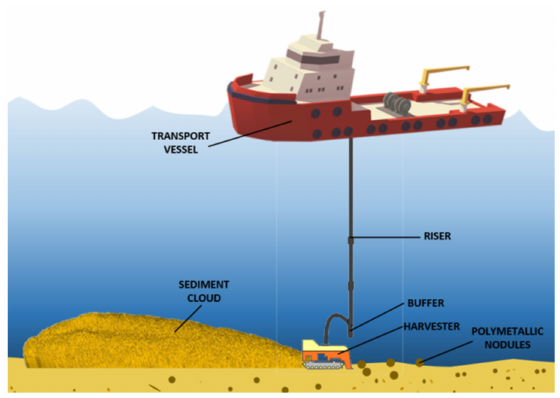
Figure 1. Diagram of harvesting the deep-sea polymetallic